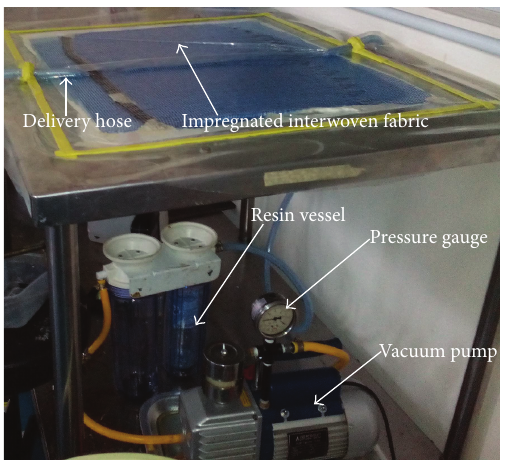
Figure 5: The complete vacuum infusion